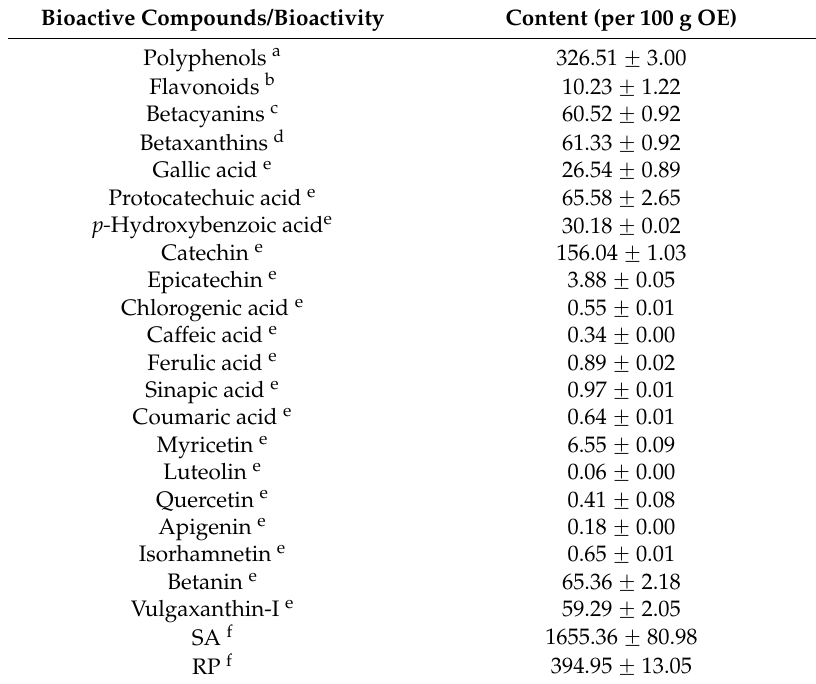
Table 4. The content of bioactive compounds and bioactivity of